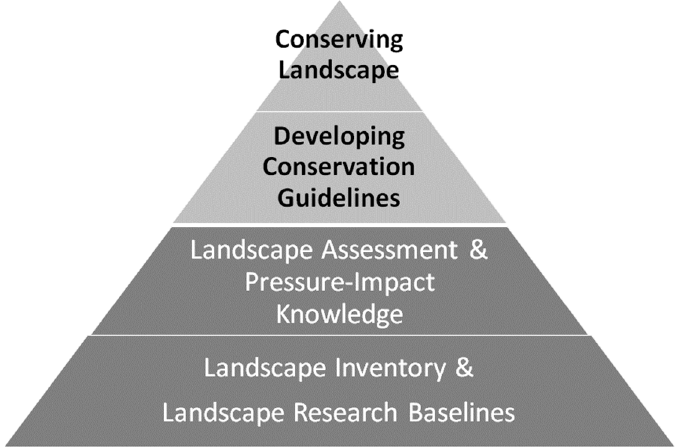
Figure 10. Why landscape assessment should be the basis for integrated nature-culture conserva- tion. Assessment methods such as LAP act in the bottom two tiers of this symbolic hierarchical pyr- amid (inspired by Feinsinger 2001